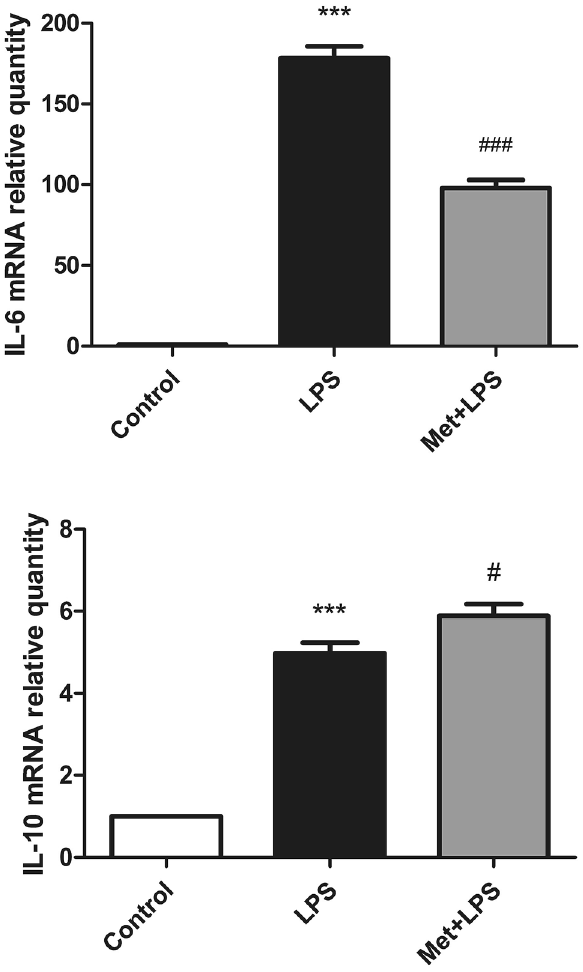
Figure 2. Effects of lipopolysaccharide and metformin on interleukin 6 and IL-10 in macrophages. LPS: lipopolysaccharide, Met: Metformin, IL-6: interleukin 6, IL-10: interleukin-10. *: compared with blank control group, #: compared with LPS group. * P < 0.05, ** P < 0.01: *** P < 0.0001. # P < 0.05, ## P < 0.01: ### P <